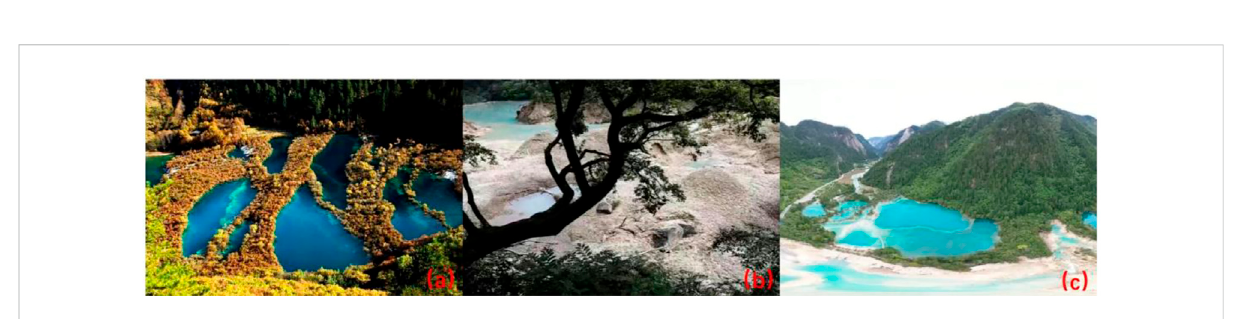
FIGURE 9 Change of Five-Flower Lake: (A) before the earthquake, (B) after the earthquake, and (C) after the ecological restoration projects.